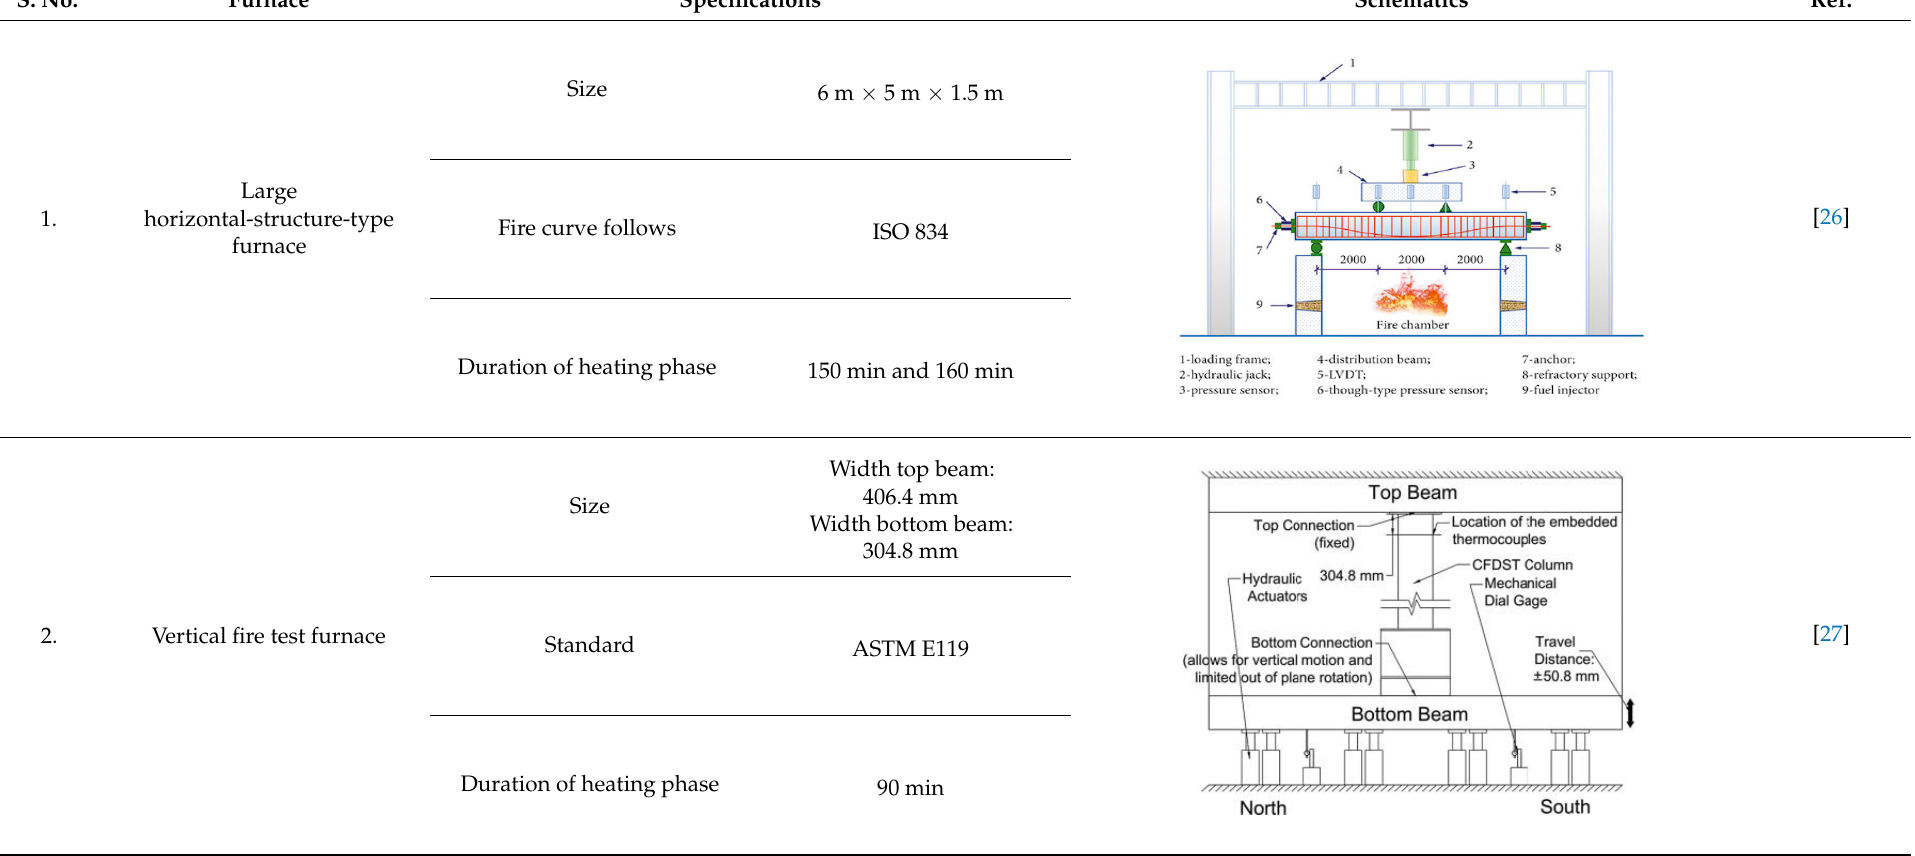
Table 8. Examples of fire-resistance test furnaces, along with their specifications and schematics. S. No.